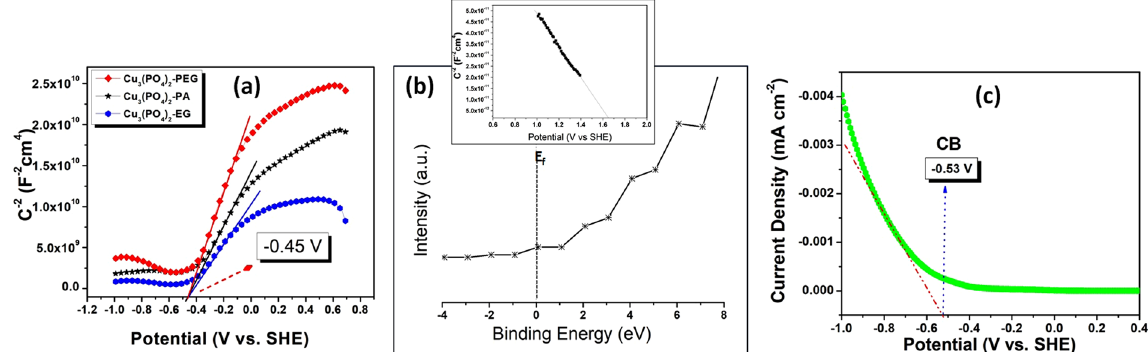
Figure 14. ( a ) Mott-Schottky plots for Cu 3 (PO 4 ) 2 -PA, Cu 3 (PO 4 ) 2 -EG, Cu 3 (PO 4 ) 2 -PEG hybrid junction measured at 1 kHz vs . standard hydrogen electrode (SHE) scale. ( b ) XPS valence spectra of the pure reduced graphene oxide exhibiting a p-type semiconducting property (inset image: Mott-Schottky relationship for RGO with the applied potential in 0.5 M Na 2 SO 4 ) ( c ) Cathodic linear potential scan converted to the SHE scale for determining the CB edge of the GO specimens at 5 mVs − 1 .